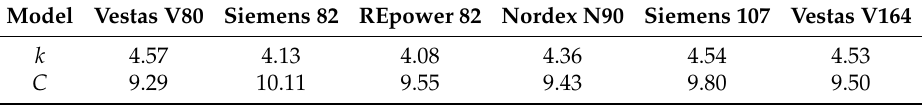
Table 5. Best case values of parameters ‘ k ’ and ‘ C ’ for several WTs.